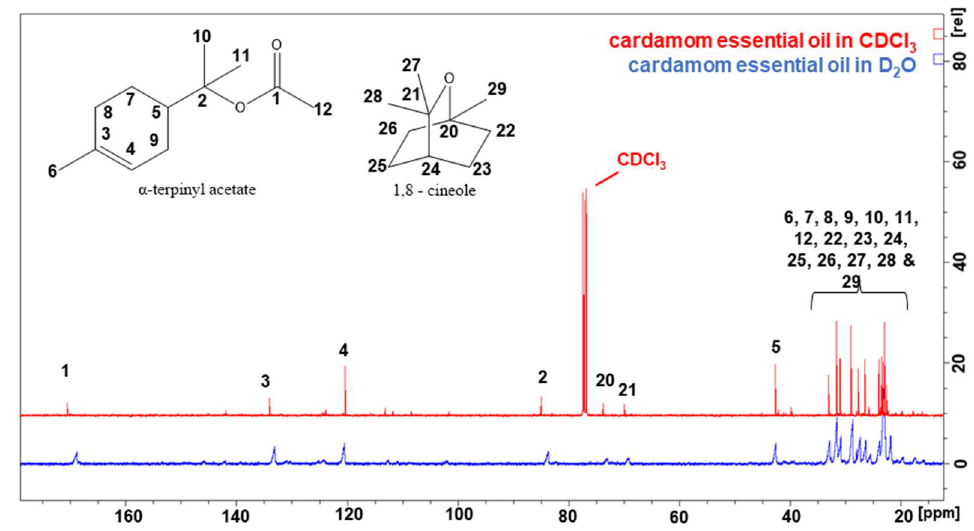
Figure 6. 13 C spectrum of EO Cardamom essential oil ( Elettaria cardamomum , CAS Number 8000-66-6) diluted with CDCl 3 and D 2 O.